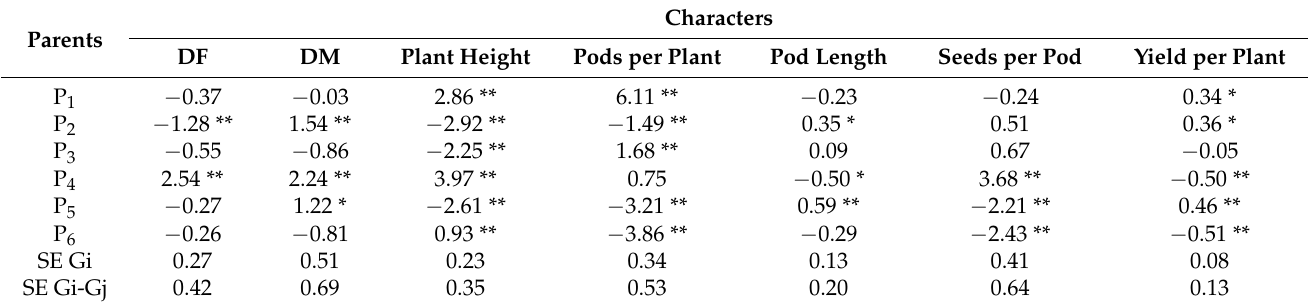
Table 3. Estimates of general combining ability effects of the parents for yield and different